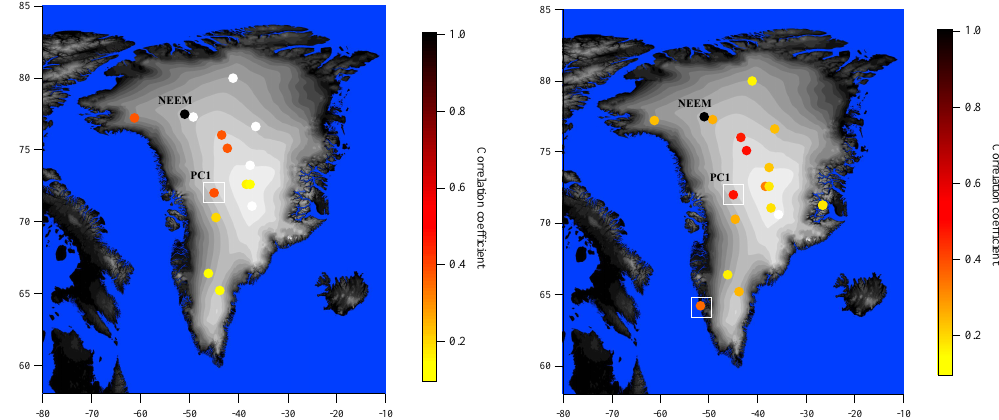
Figure 4. Spatial distribution of correlation coefficients between NEEM accumulation (top) and other Greenland accumulation records, and between NEEM δ 18 O (bottom) and other Greenland temperature and δ 18 O records. We have also displayed the correlation with the PC1 of other Greenland records (white rectangle) and the correlation with SW Greenland instrumental temperature data (repeating the same value for the three coastal sites used to make the temperature stack record) (white rectangles). We used correlation coefficients for the same period (1761–1966), without detrending (Tables S1, S2 and S3 in the Supplement). Note that insignificant correlations are represented by the white filled circles.